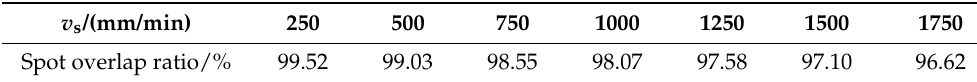
Table 3. The spot overlap ratios of polished mold steel.